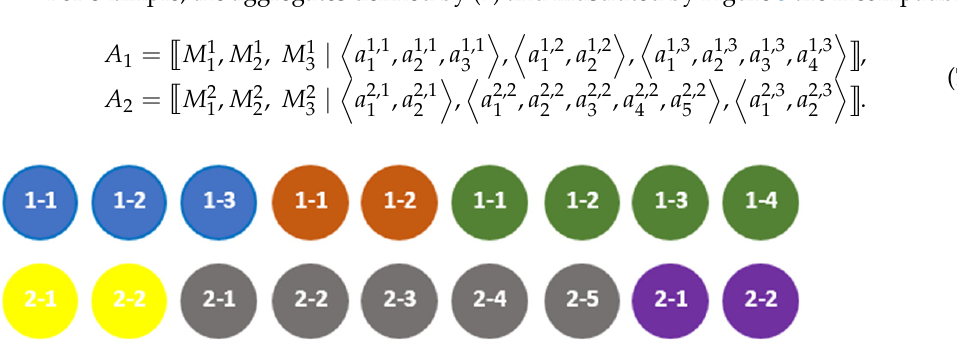
Figure 1. An example of two compatible aggregates.